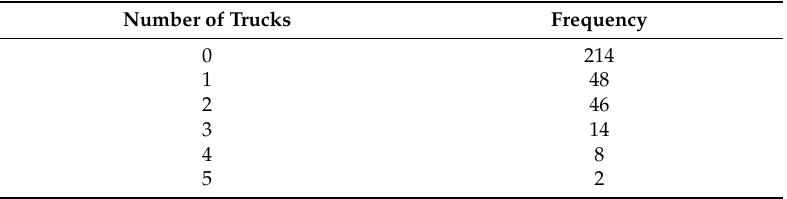
Table 1. Frequencies of the input flow for a period of one